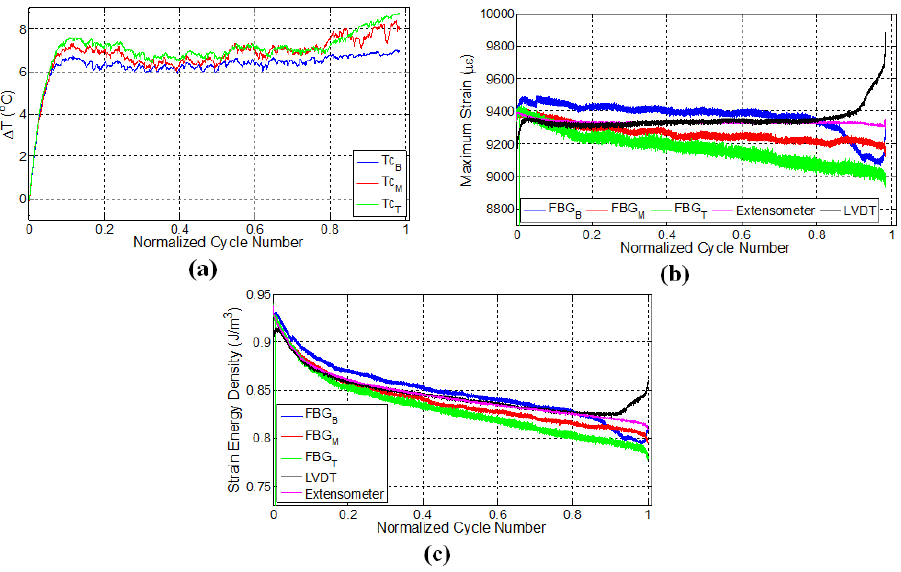
Figure 6. Evolution of ( a ) temperature; ( b ) strain and ( c ) strain energy density for specimen